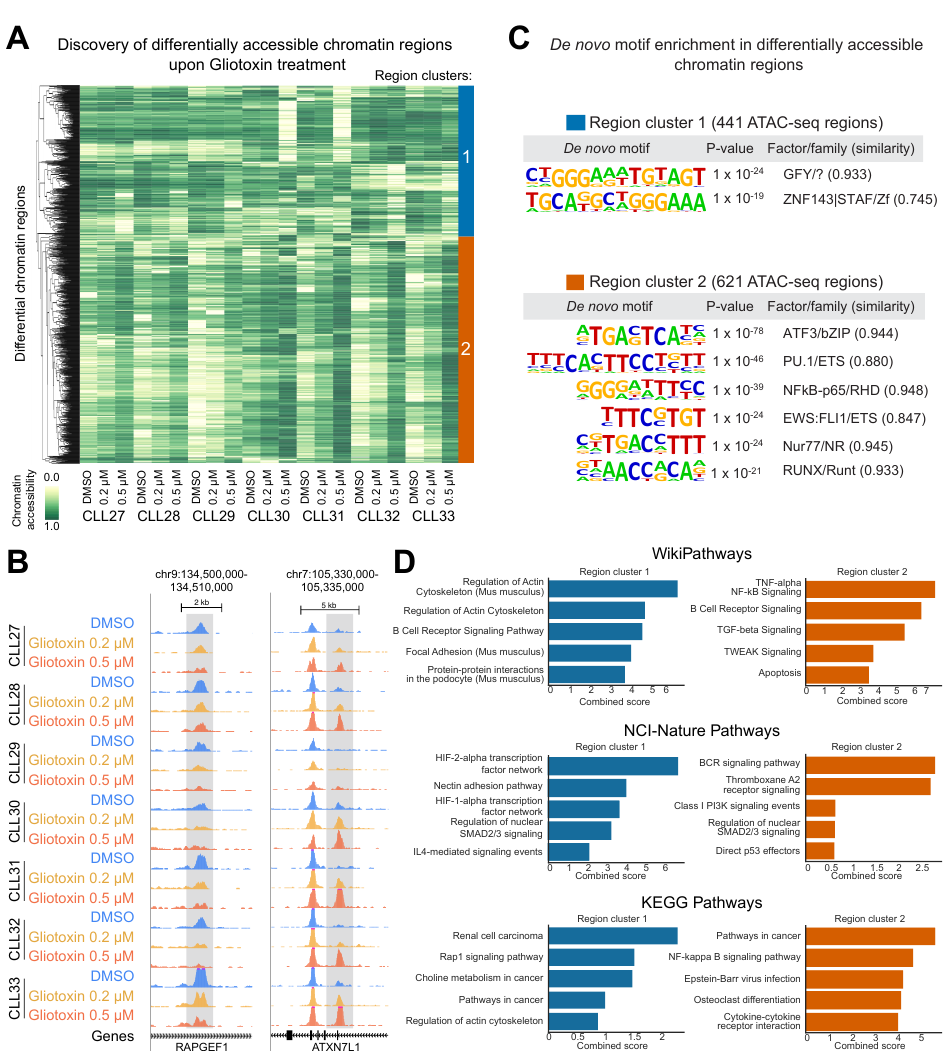
Figure 7. Chromatin gliotoxin treatment-related changes in chromatin accessibility in CLL cells. ( A ) Clustered heatmap based on all the di ff erentially accessible regions between treatment conditions. ( B ) Representative browser visualization of genomic regions that lost (left panel for RAPGEF1 ) or gained (right panel for ATXN7L1 ) chromatin accessibility upon gliotoxin treatment. ( C ) De novo motif enrichment analysis of di ff erentially accessible regions from Region Clusters 1 and 2. ( D ) Most highly enriched pathways for genes associated with Region Clusters 1 and